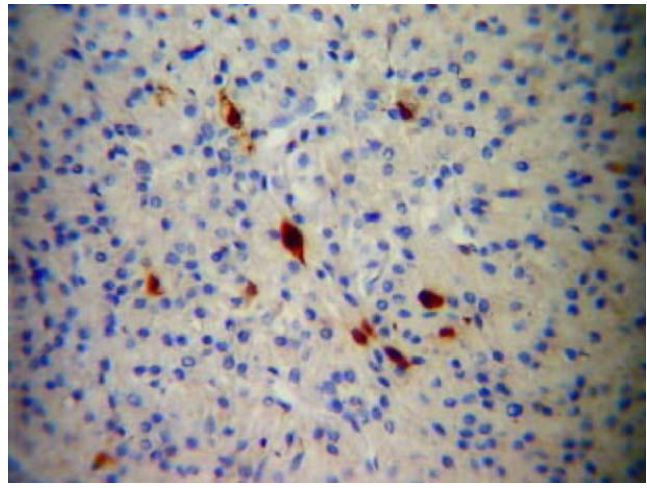
Fig. 4 Ki67 protein in raw micrograph of a parathyroid gland.